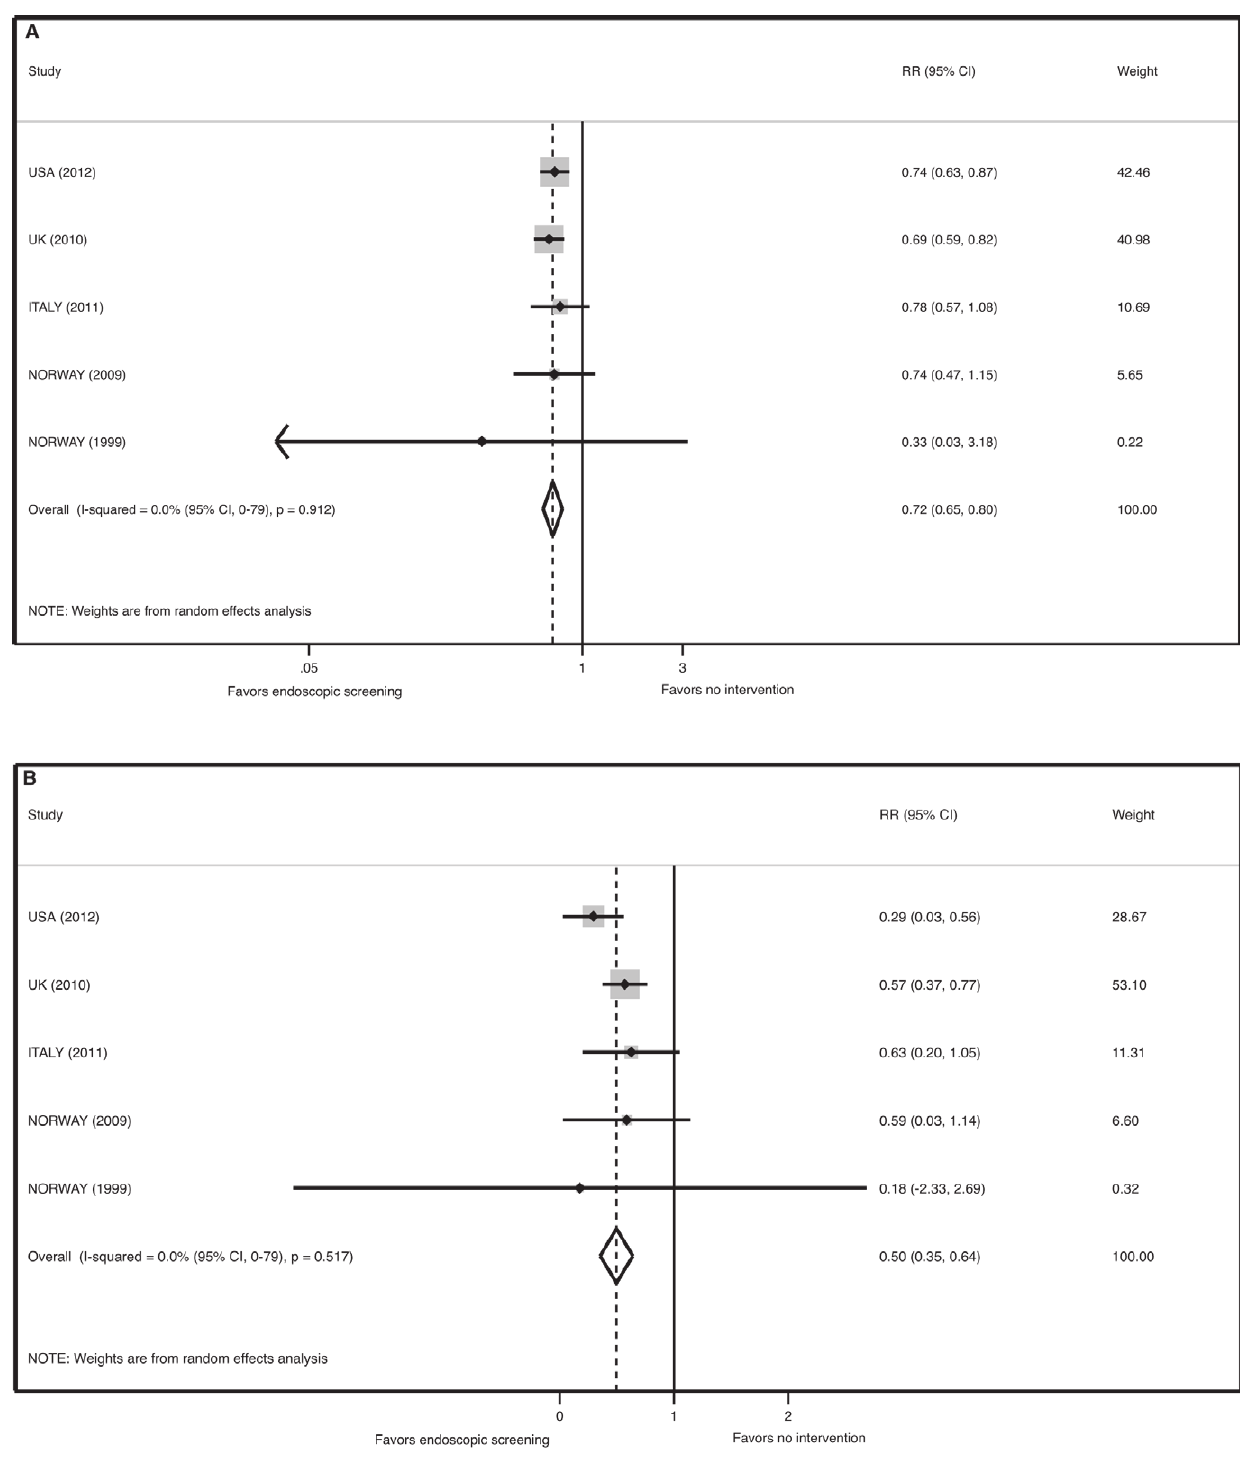
Figure 3. Meta-analysis of the effect of endoscopic screening on colorectal cancer mortality. (A) Pooled relative risk of ITT analyses. (B) Pooled relative risk of efficacy estimates.